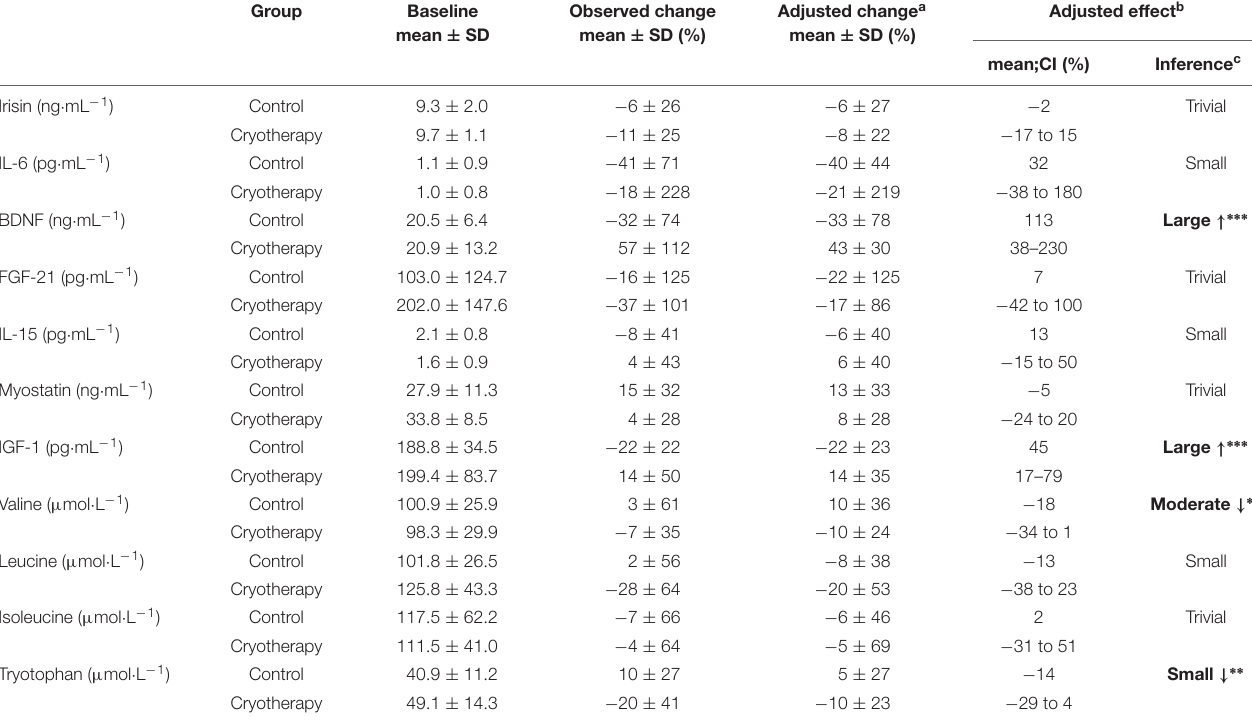
TABLE 5 | The effect of nine sessions of whole body cryostimulation or passive rest on immunological response and amino acid profile among all